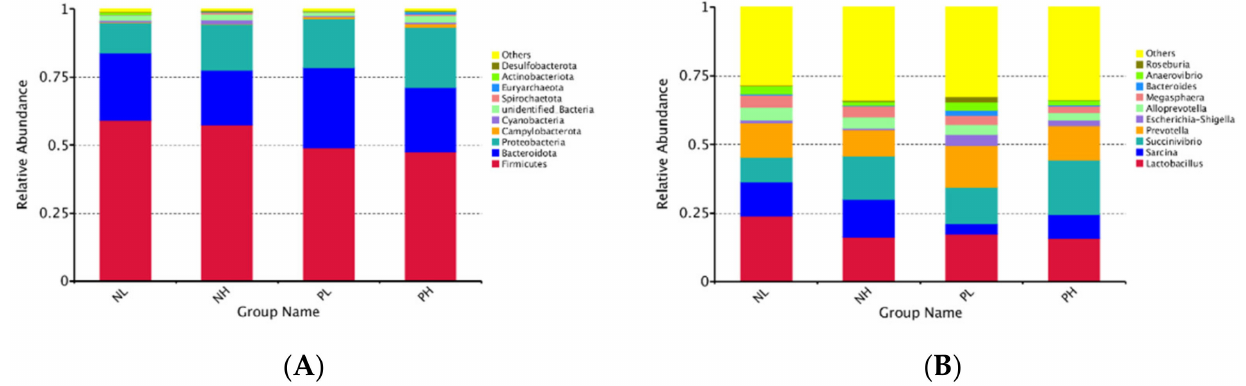
Figure 5. Effects of different moisture contents (adding 7.5 vs. 15% water) and enzyme additions (adding 4 kg/t α -amylase or not) to extruded corn on the relative abundances of gut microbiome phyla ( A ) and genus ( B ) in weaned piglets. The abundance is expressed in terms of a percentage. NL, adding 7.5% water before corn extrusion; NH, adding 15.0% water before corn extrusion; PL, adding 7.5% water and 4 kg/t α -amylase before corn extrusion; PH, adding 15% water and 4 kg/t α -amylase before corn